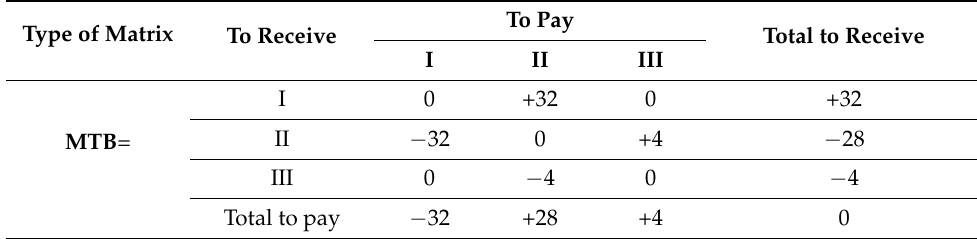
Table 6. The Matrix of a Trial Balance MTB in matrix